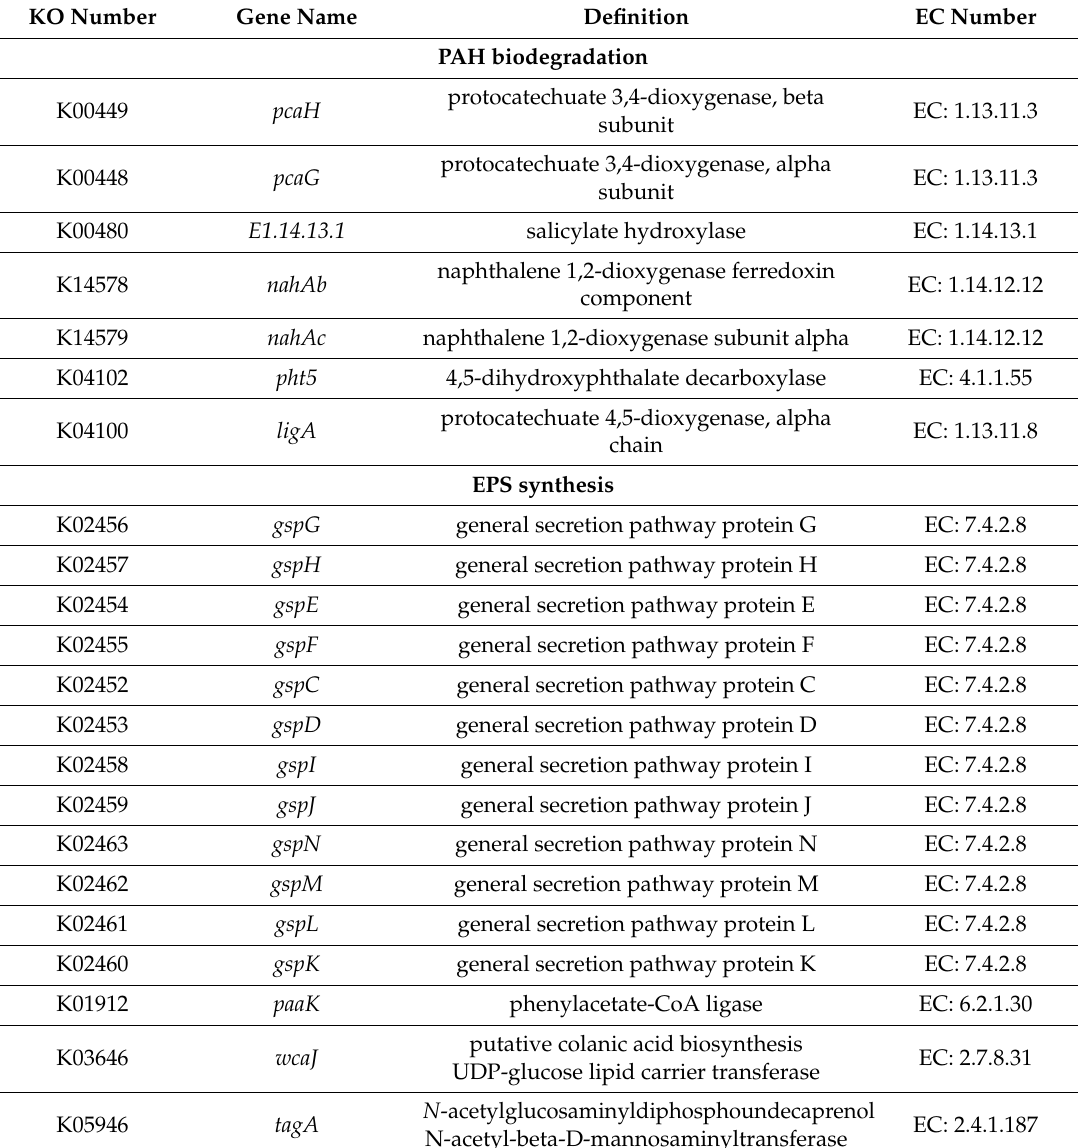
Table 2. Characterization of the analyzed Kyoto Encyclopedia of Genes and Genomes